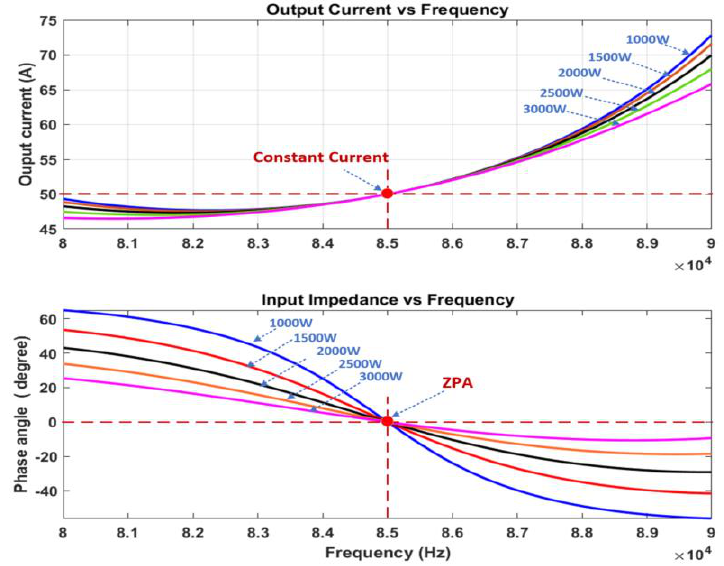
Figure 30. Output current and phase angle versus frequency of proposed IPT design at various output powers.